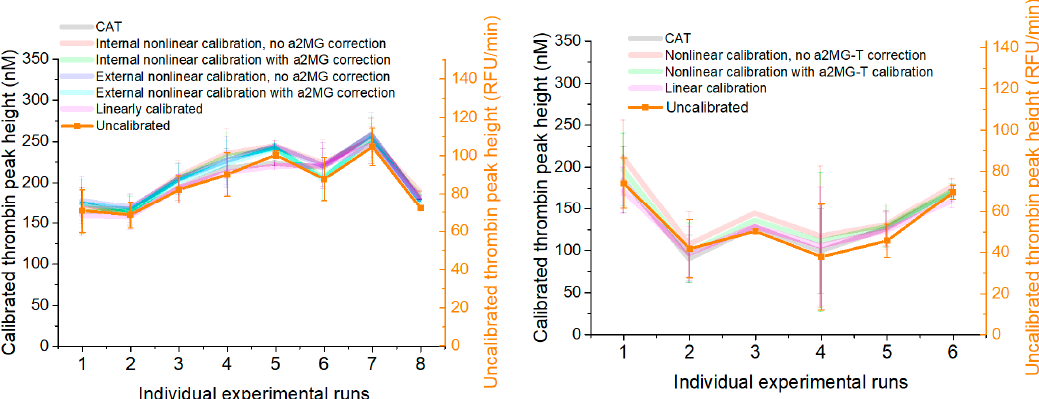
Figure 5. Impact of external and internal correction algorithms on run-to-run consistency in TPHs in normal PFP and PRP. Left panel : Normal PFP triggered with 1 pM TF; Right panel: Normal PRP triggered with 1 pM TF. Left axis: Calibrated TPH values for the normal plasma condition of each run are shown. The uncalibrated TPH axis ( right ) is scaled using the linear regression slope obtained from the composite external calibration curve.